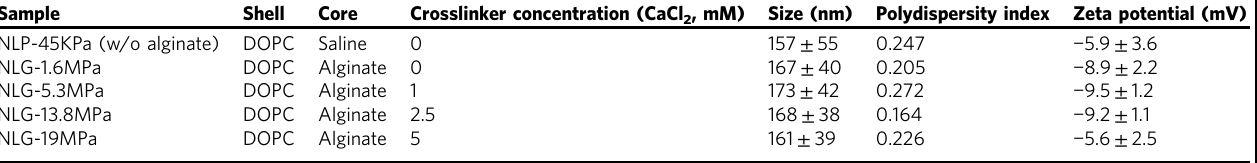
The mean values and error bars are de fi ned as mean and S.D.,